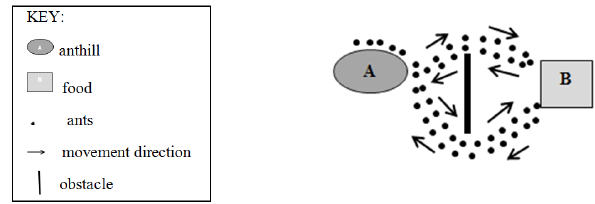
Figure 3: Diagram of path selection by ants after an obstacle has appeared on the road